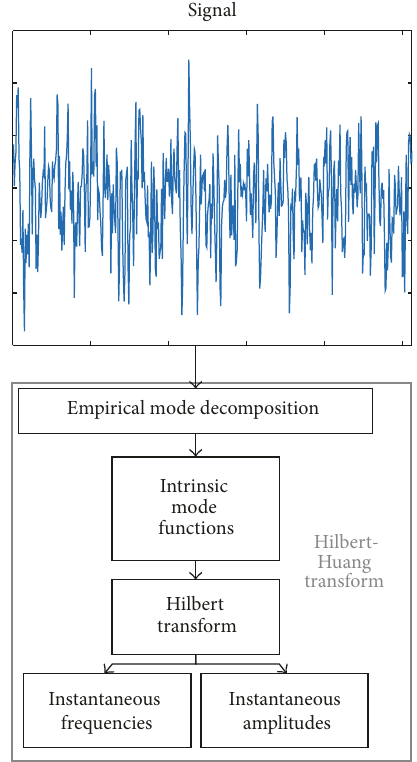
Figure 5: Overview of HHT adapted from Wang